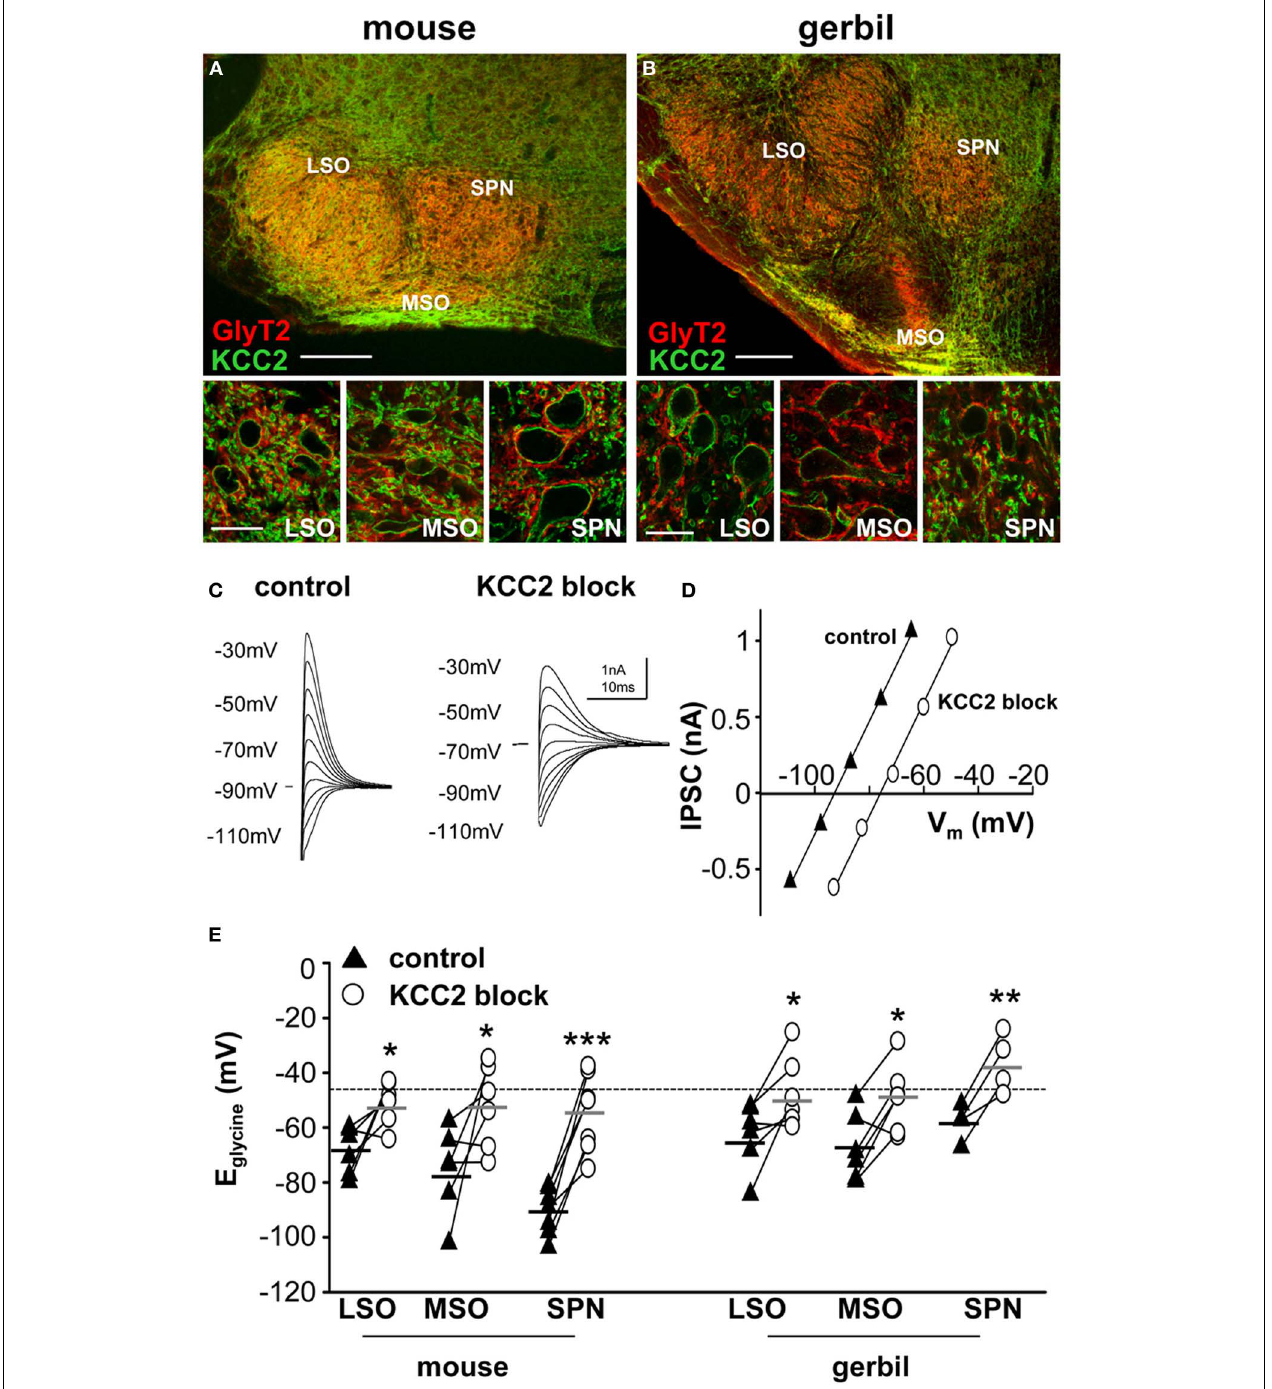
FIGURE 1 | KCC2 mirrors the expression of GlyT2 in the superior olivary complex. Overview of mouse (A) and gerbil (B) SOC and enlarged images of LSO, MSO, and SPN double-labeled for GlyT2 (red), and KCC2 (green). Scale bars: 200 µ m in overviews, 25 µ m in magnified images. (C) Glycinergic IPSCs were evoked in a mouse SPN neuron by electrical stimulation of the MNTB. The command potentials ranged from − 120 to − 30mV in steps of 10mV. The IPSC reversal potential changed from − 90mV in control conditions (closed triangles in panel D ) to − 70mV after the blockade of KCC2 (open circles in panel D ) with furosemide. Stimulus